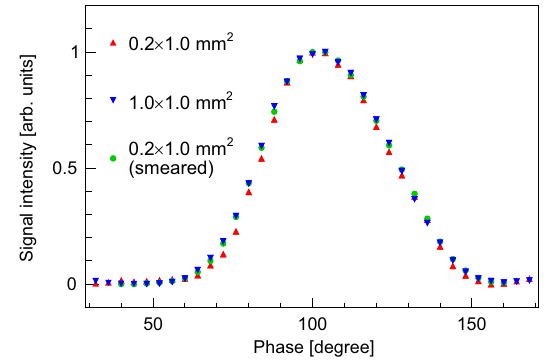
FIG. 9. Comparison of longitudinal phase distributions mea- sured with different sizes of HOPG targets.